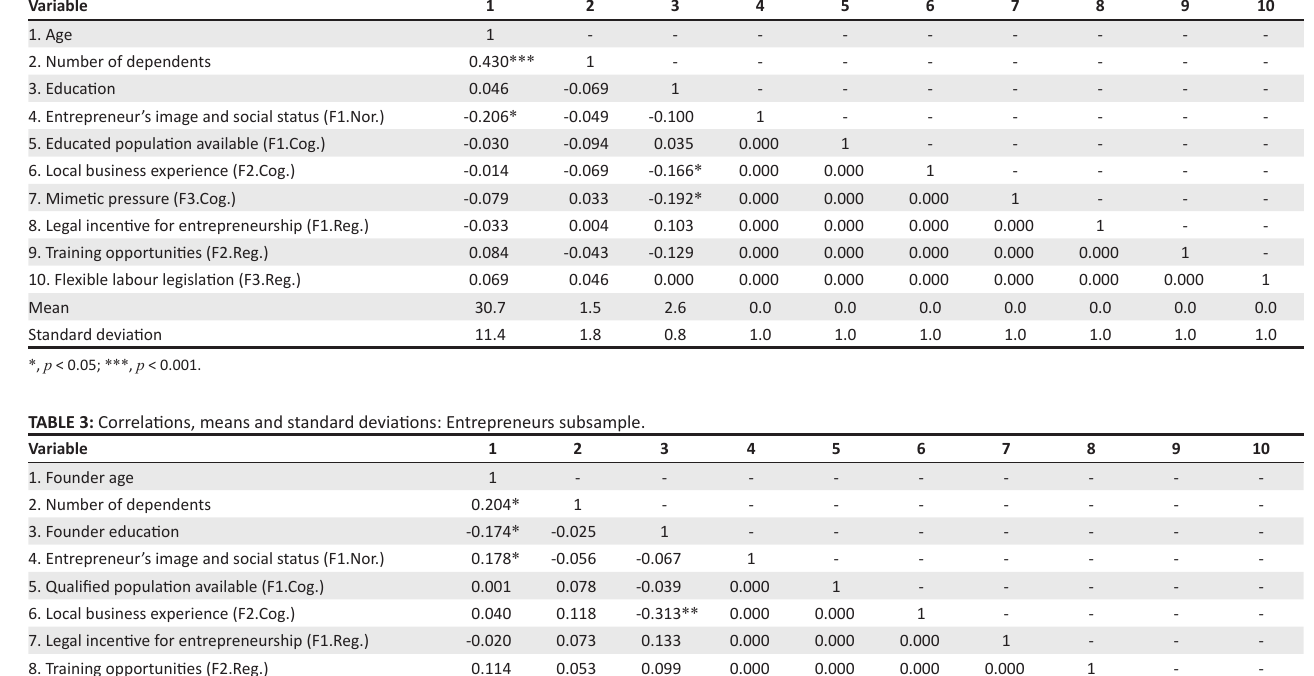
TABLE 2: Correlations, means and standard deviations: Non-entrepreneurs subsample. Variable